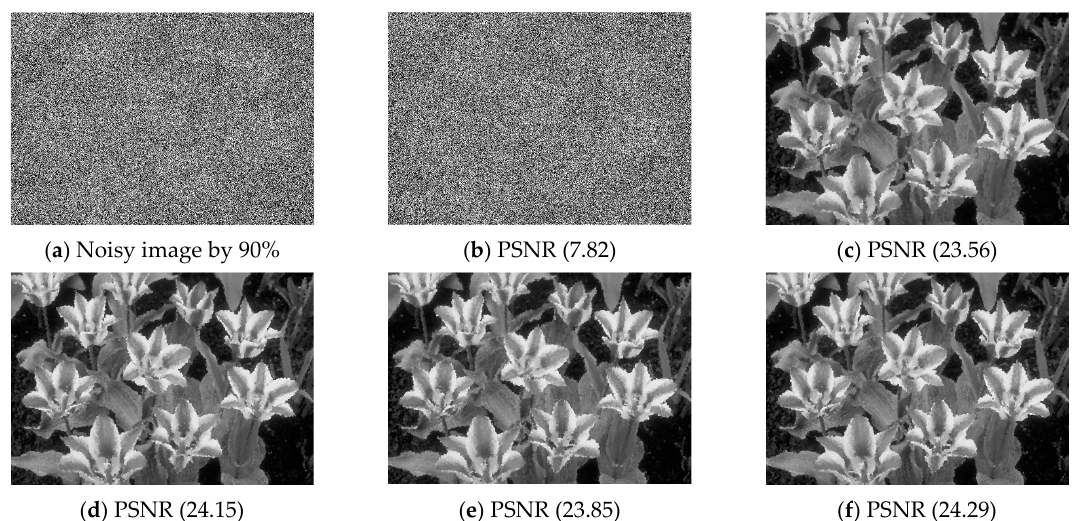
Figure 5. Noised “ Tulips ” image by 90% fixed value impulse noise and its restored images by different state-of-art and their PSNR. ( a ) Noisy “ Tulips ” image ( b ) EDF+BDND ( c ) IGMF+FTD ( d ) ASWMF+D3PLS ( e ) NBMF+VTD ( f ) The proposed state-of-art.